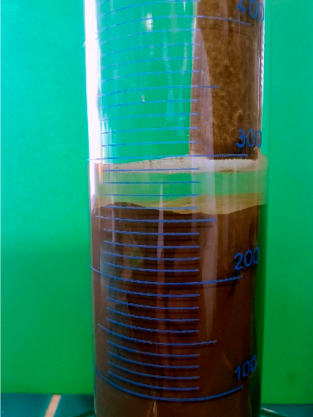
Figure 1. Free water in highly fractionating cement